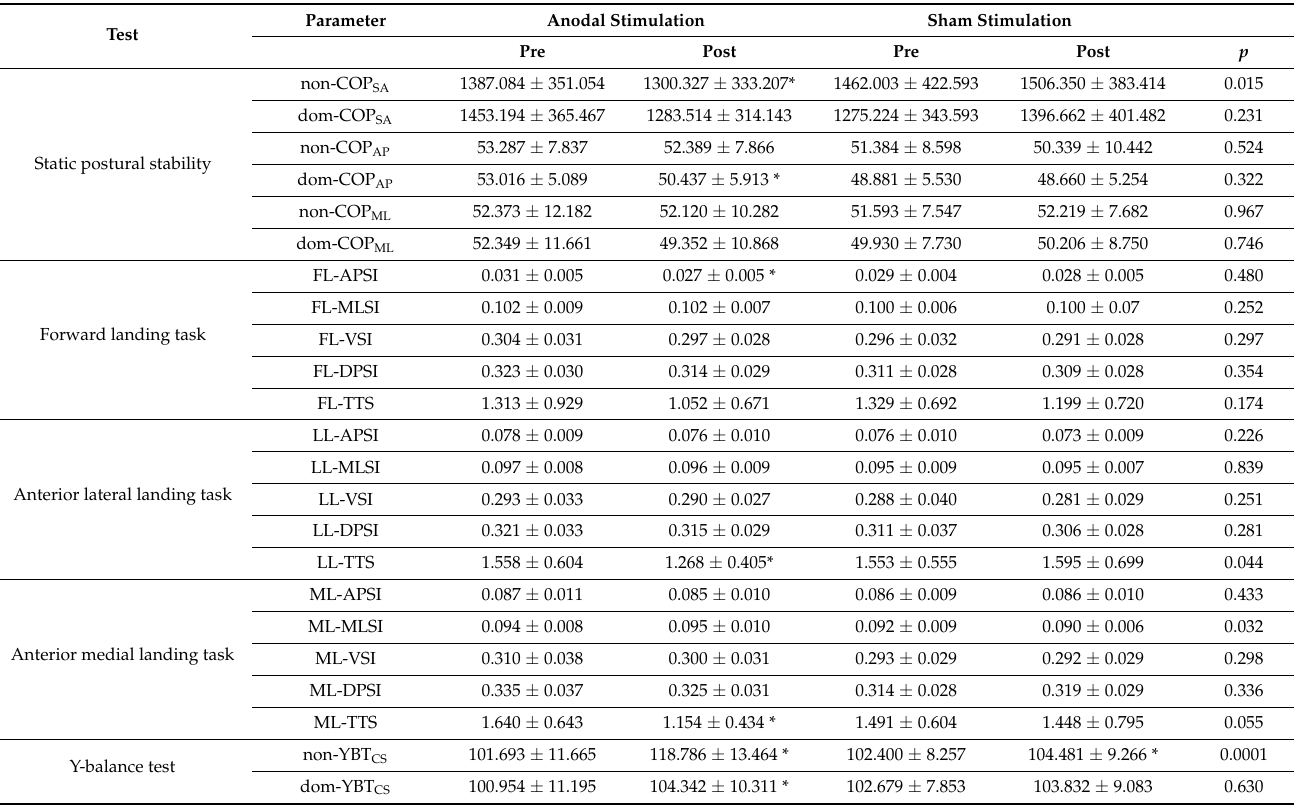
Table 2. Static and dynamic postural stability scores before and after anodal or sham tDCS intervention (Mean ±